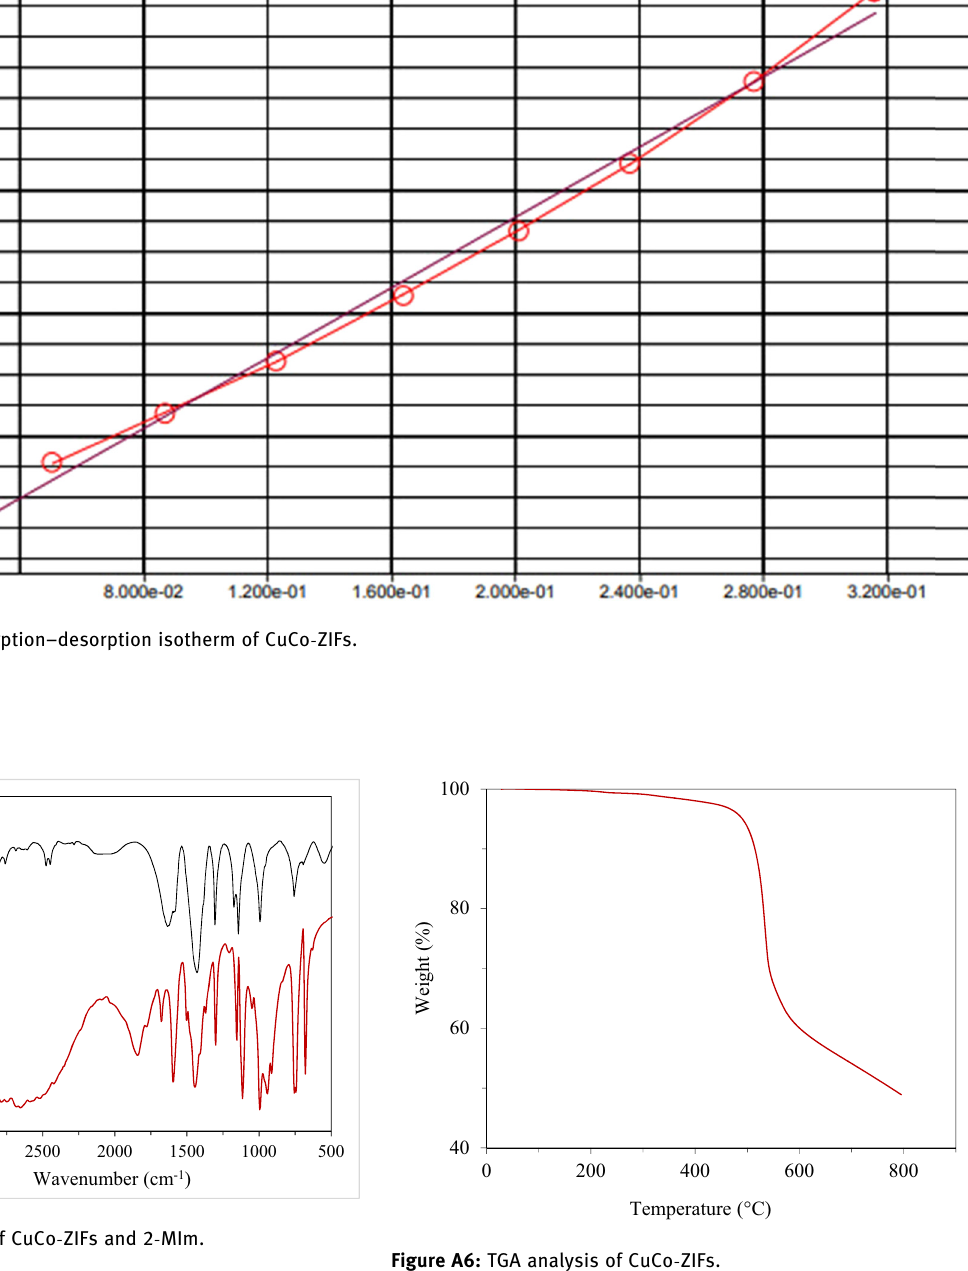
Figure A6: TGA analysis of CuCo -